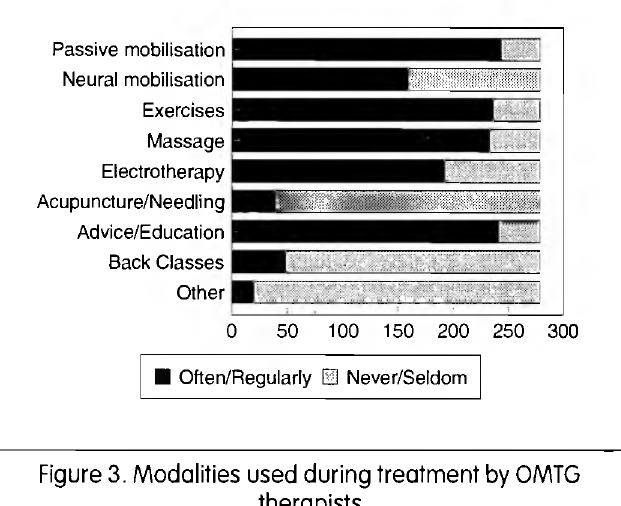
Figure 3. Modalities used during treatment by OMTG